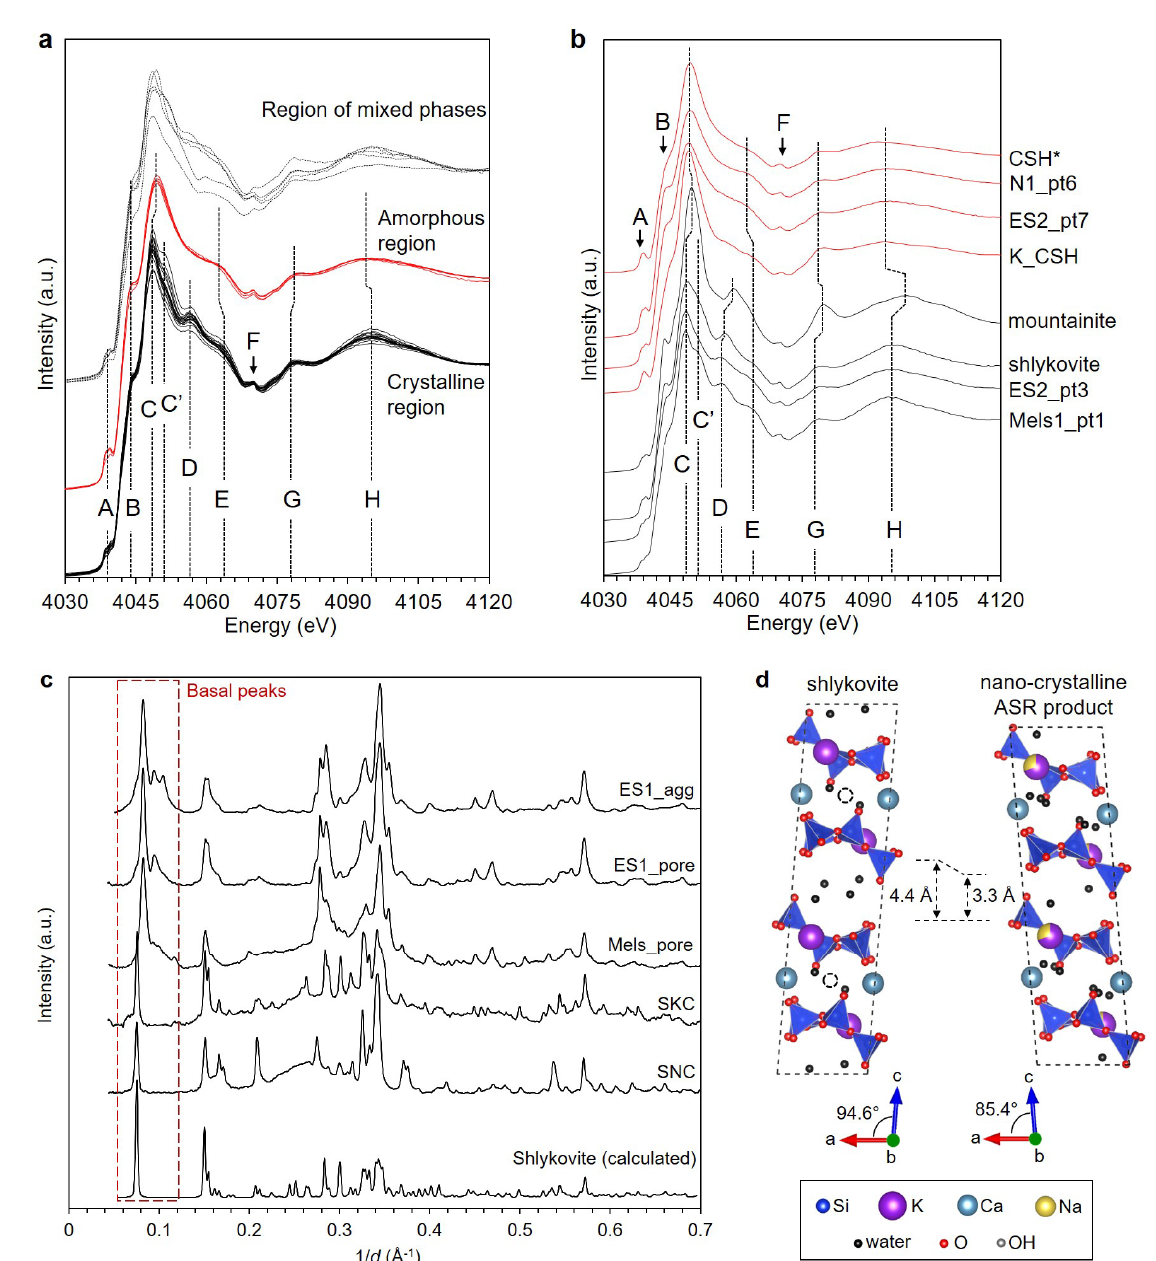
Figure 7. (a) The Ca K ‐ edge XAS of the ASR products in an ASR ‐ damaged concrete, (b) and the comparison with reference minerals and lab ‐ synthesised ASR products. (c) The XRD of field ASR samples (ES1_agg, ES1_pore, Mels_pore), lab ‐ synthesised sample (SKC, SNC) and shlykovite (theoretical calculation). (d) The postulated structure of crystalline ASR product in comparison with shlykovite (adapted from